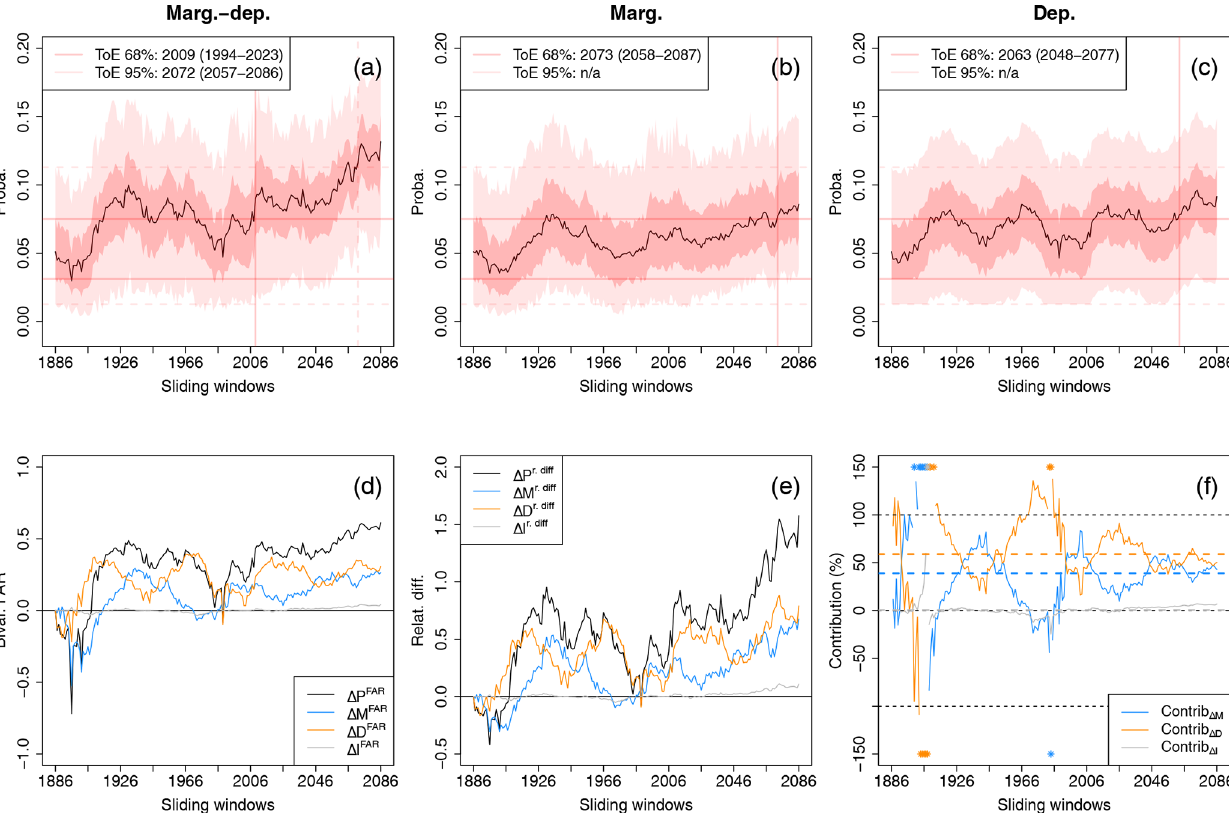
Figure 5. (a–c) Probability changes and time of emergence of compound wind and precipitation extremes (cid:0) P (cid:0) X > x 80 | sel ∩ Y > (cid:1)(cid:1) based on CNRM-CM6 simulations due to changes of (a) both marginal and dependence properties, y 80 | sel | (X,Y) ∈ S CNRM-CM6 90 , 90 (b) marginal properties only, and (c) dependence properties only. The shaded bands indicate 68% and 95% confidence intervals of the probabilities. Evolution of (d) the bivariate fraction of attributable risk (FAR), (e) relative difference of probabilities with respect to the refer- ence period (1871–1900) and (f) contribution of the marginal, dependence and interaction terms to probability values. Median contributions computed over all sliding windows are displayed with dashed lines. Asterisks indicate values lying outside the plotted range. Not applicable (n/a) is indicated when no time of emergence is